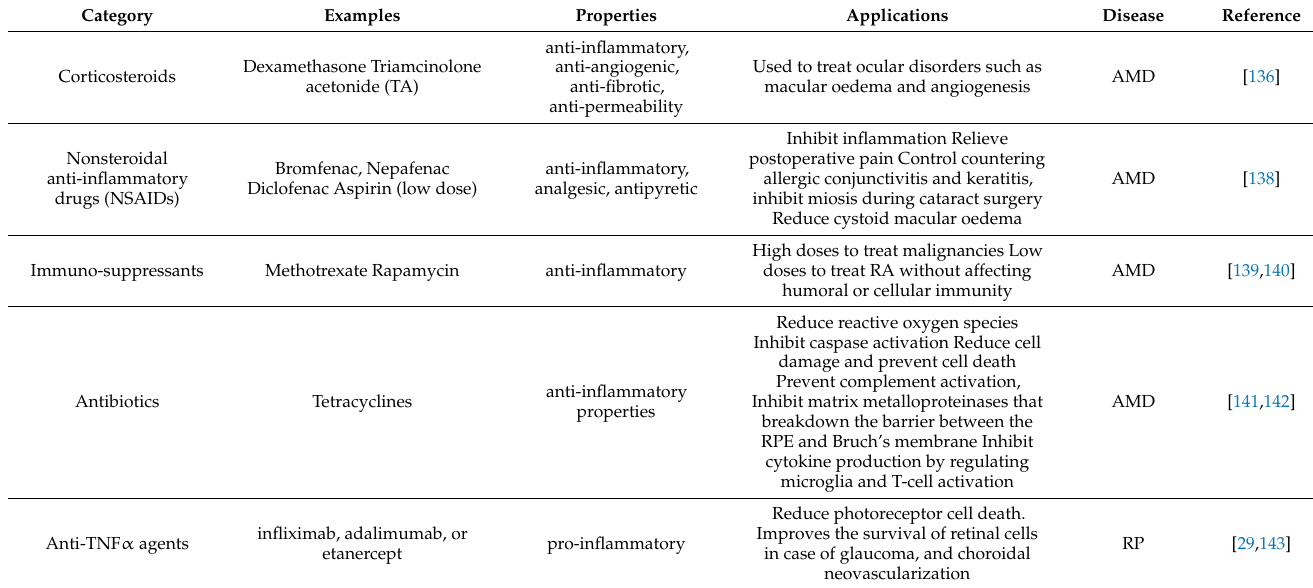
Table 2. Currently available treatments for retinal degenerative